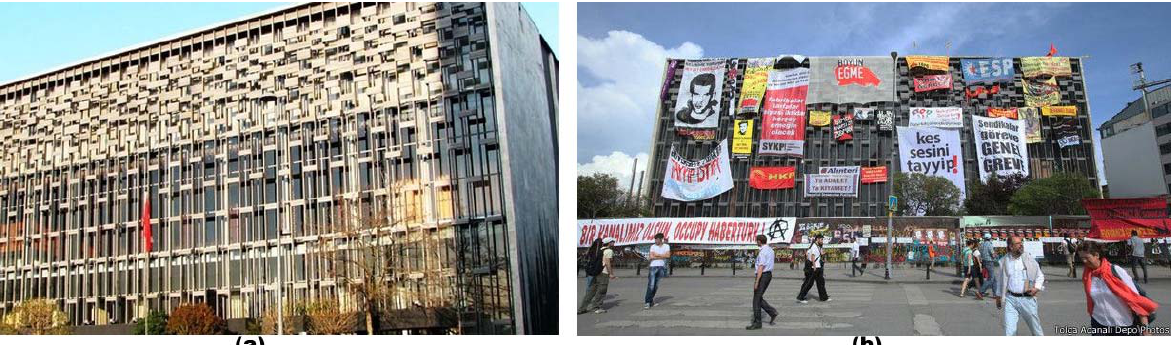
Figure 5: Atatürk Cultural Centre (a): before protests (Karakoç, www.arkitera.com/haber); (b): 2013 (https://istanbultourstudio.com) The republic monument in Taksim Square also has a significant importance in Turkish history. After the establishment of the Republic of Turkey, Ankara was assigned as the capital of the new republic. However, the Taksim area was already a symbol of a western-lifestyle since the late Ottoman period (Figure 6).